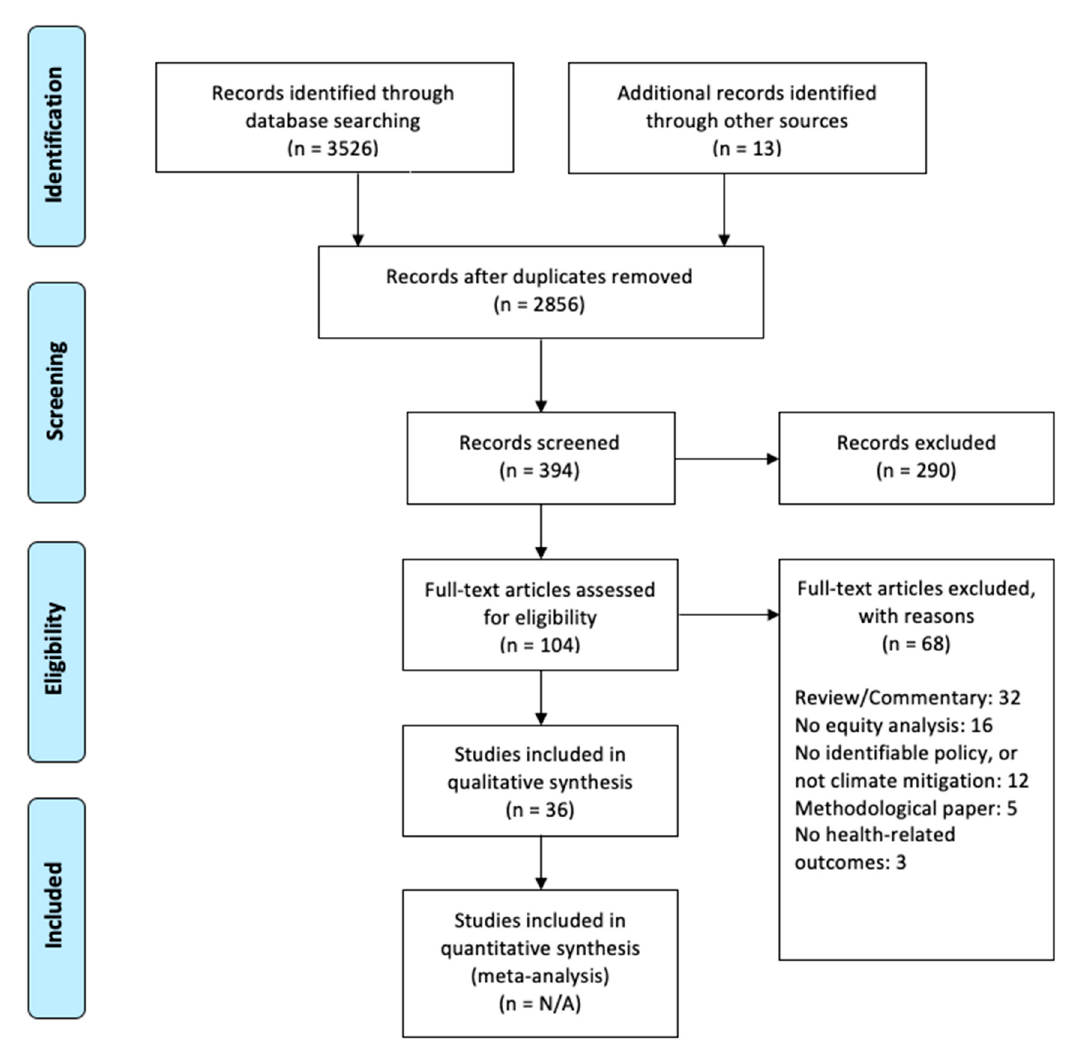
Figure 1. Preferred Reporting Items for Systematic Reviews and Meta-Analyses (PRISMA) flow diagram for study inclusion.